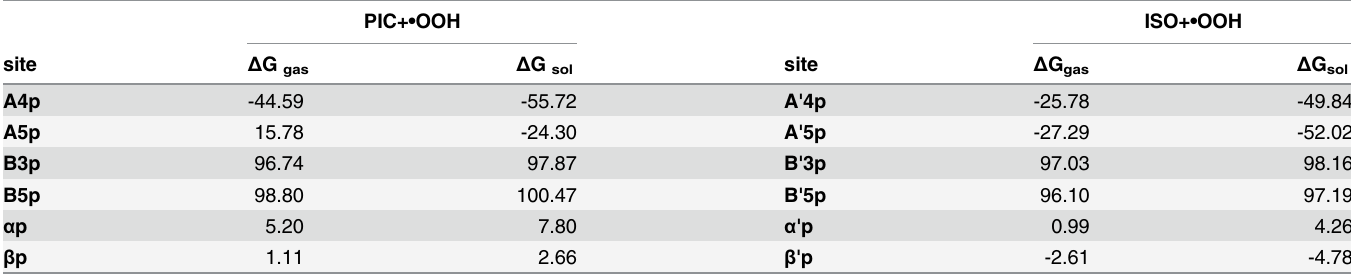
Table 4. The reaction Gibbs energies for reactions of PIC and ISO with (cid:129) OOH in the gas phase and water (in kJ/mol). PIC+ (cid:129)